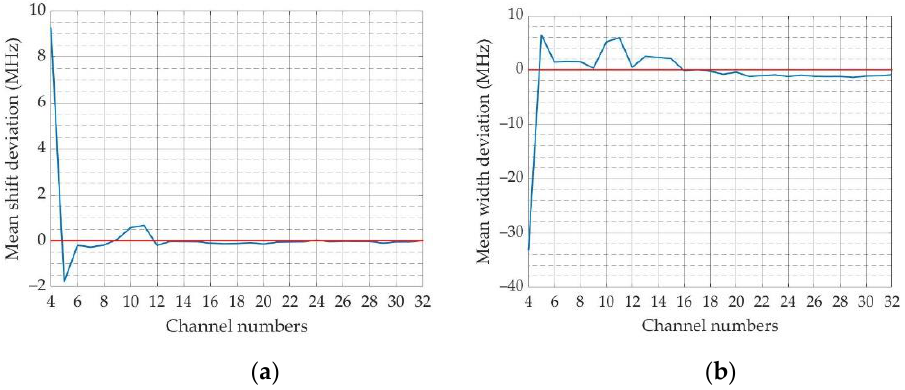
Figure 4. Deviations under different channel numbers of the PMT: ( a ) Brillouin shift; ( b ) Brillouin linewidth.